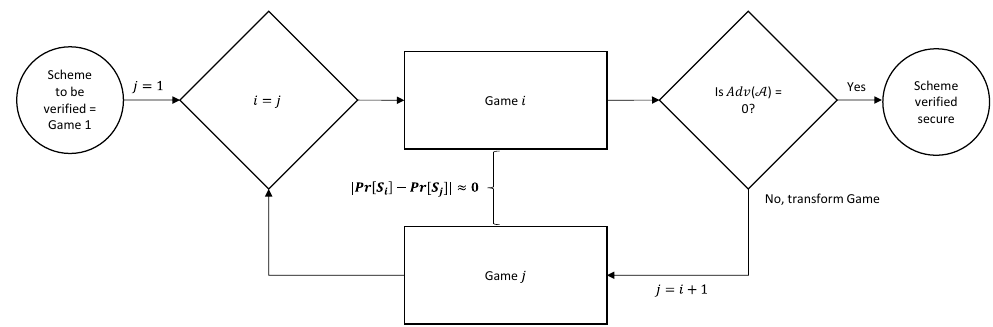
Figure 8. Security Verification by the Game-Hopping Process of CryptoVerif.